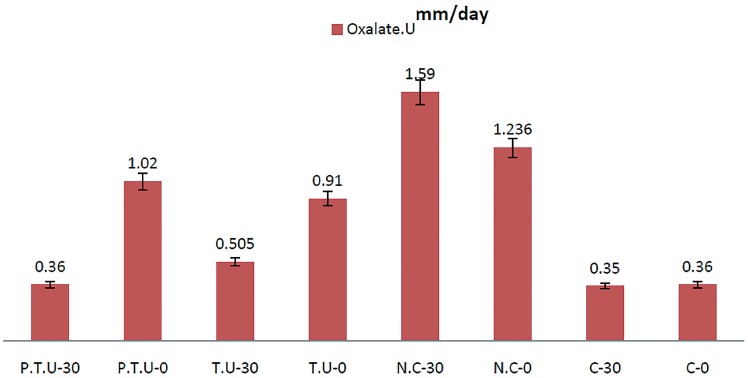
Urinary Oxalate level in all groups in 0- and −30 daysw.